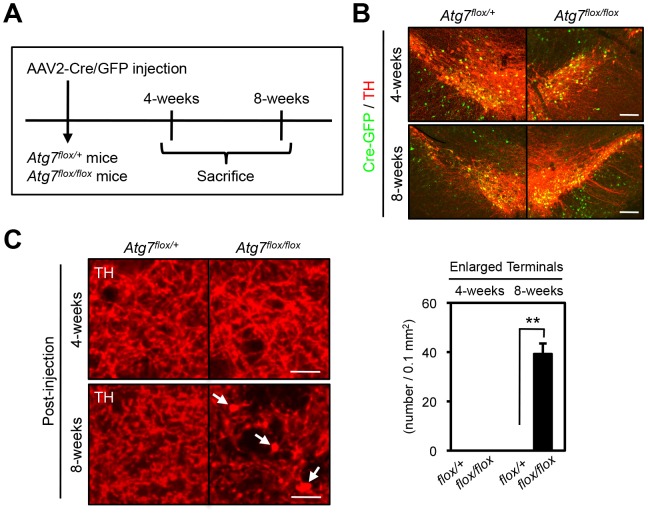
Atg7 regulates morphological plasticity of mature dopaminergic axon terminals.(A) Scheme of AAV2-Cre/GFP viral transduction of adult Atg7flox/flox substantia nigra. Eight-week-old Atg7flox/+ and Atg7flox/flox mice were stereotactically injected with AAV2-Cre/GFP viral solution, and sacrificed 4- or 8-weeks later. (B) AAV2-Cre/GFP viral transduction of substantia nigra led to prominent GFP fluorescence (green) in a majority of TH-positive DA neurons (red) at 4- or 8-weeks after the injection; no GFP fluorescence was seen in untransduced animals (data not shown). (C) Transduction of Cre/GFP virus into adult Atg7flox/flox substantia nigra reproduced the enlarged axon terminal phenotype seen in Atg7 cKO mice. At 8-weeks after injection, enlarged TH-positive axon terminals (arrows) were seen in the striatum of Atg7flox/flox mice injected with AAV2-Cre/GFP viral solution. No enlarged axon terminals were seen in the striatum of Atg7flox/+ mice with AAV2-Cre/GFP virus or Atg7flox/flox mice with control AAV2-GFP virus lacking Cre. Bars, 20 µm. (right) Quantification of the density of enlarged axon terminals in mice injected with AAV2-Cre/GFP virus. TH-positive axon terminal enlargement in Atg7flox/flox mouse striatum was seen at 8-weeks after the AAV2-Cre/GFP virus injection. White, Atg7flox/+; Black, Atg7flox/flox. n = 3 per group. **, p<0.01.